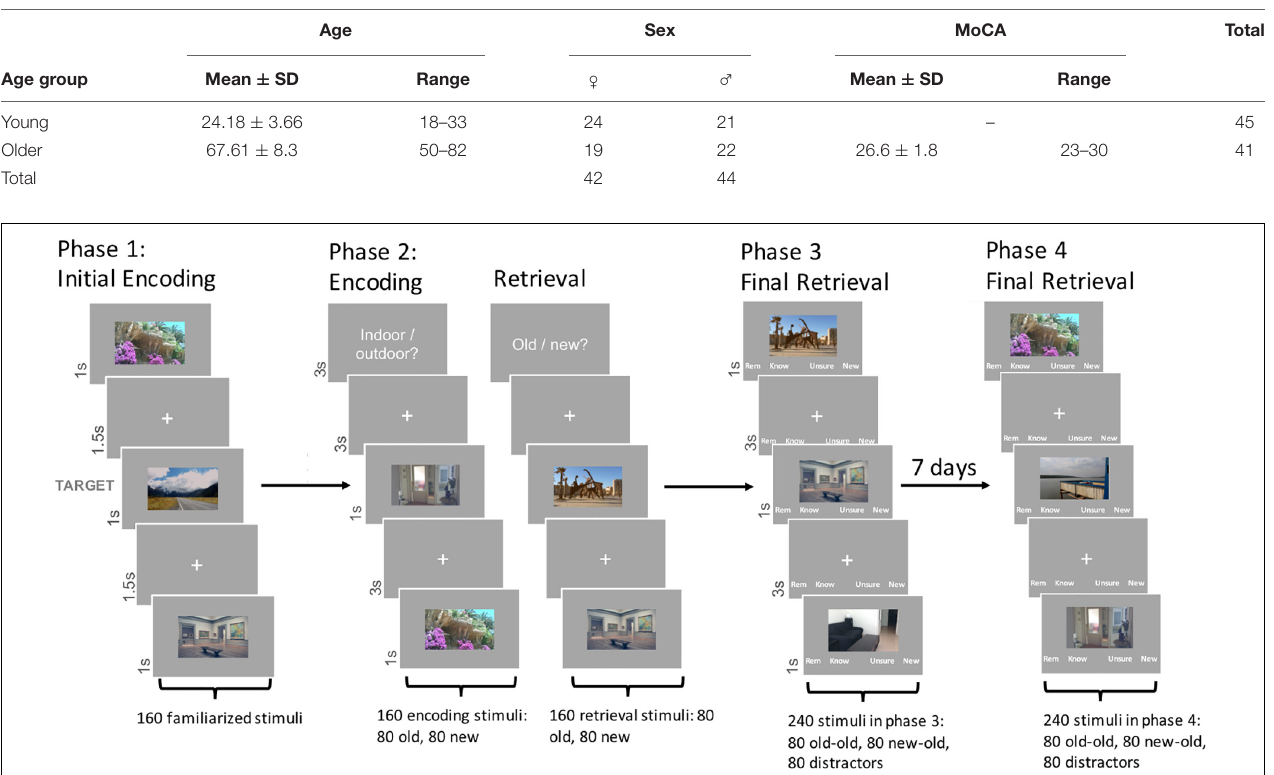
TABLE 1 | Demographic data for the younger and older subsample.